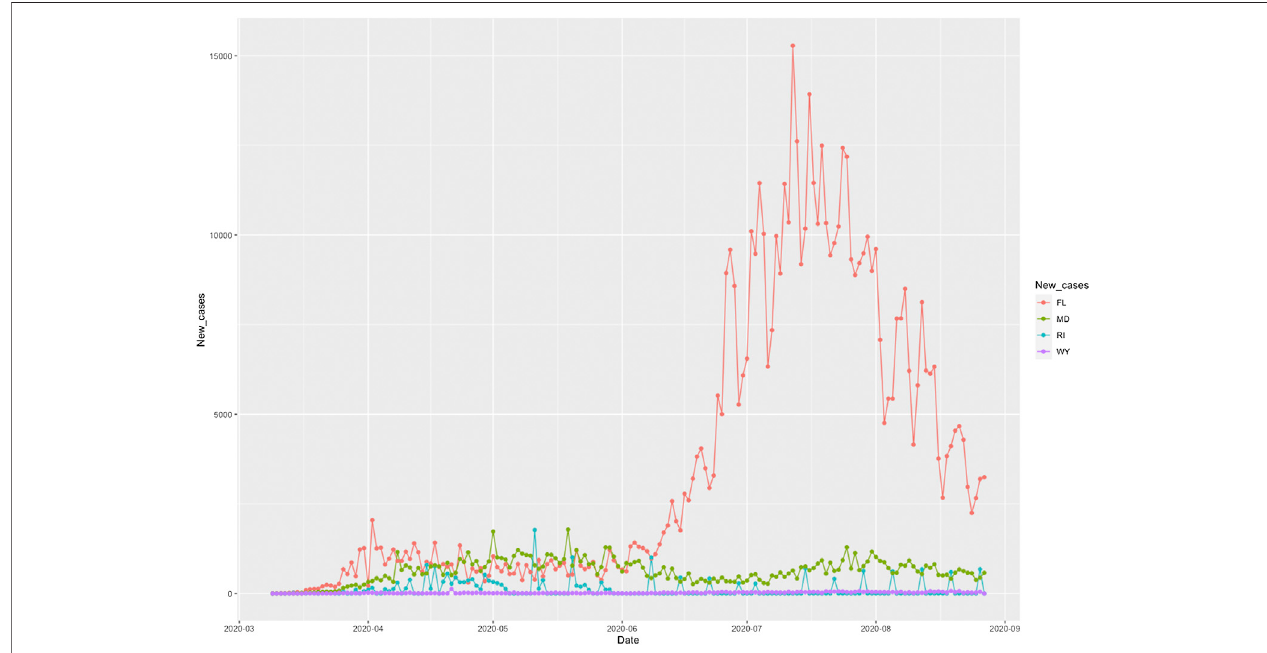
FIGURE 3 | Number of new cases ofCOVID-19as a function of time from March 5, 2020 toAugust 25, 2020 in Florida(FL), RhodeIsland (RI), Maryland (MD), and Wyoming (WY).